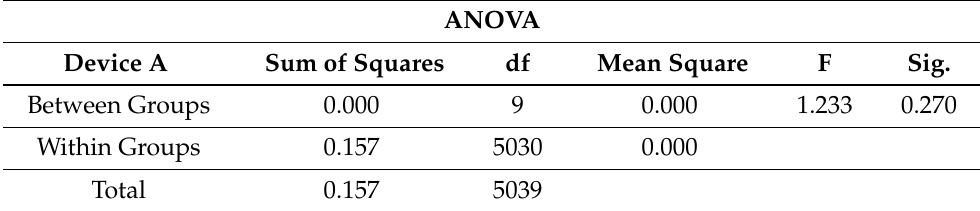
Table 3. Results for ANOVA.